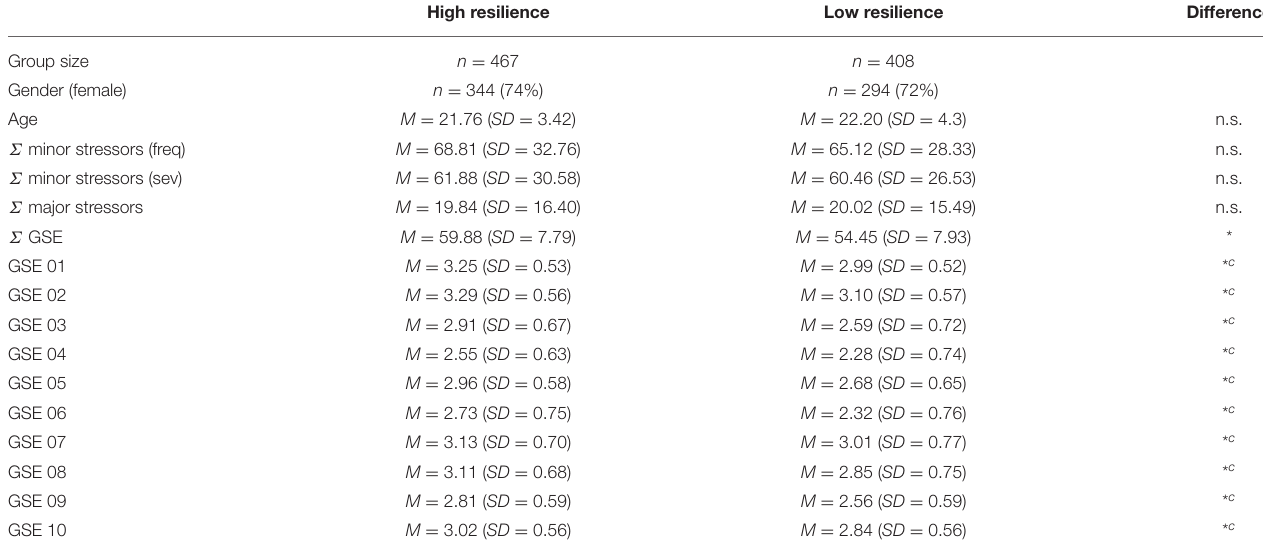
TABLE 1 | Characteristics of and differences between both